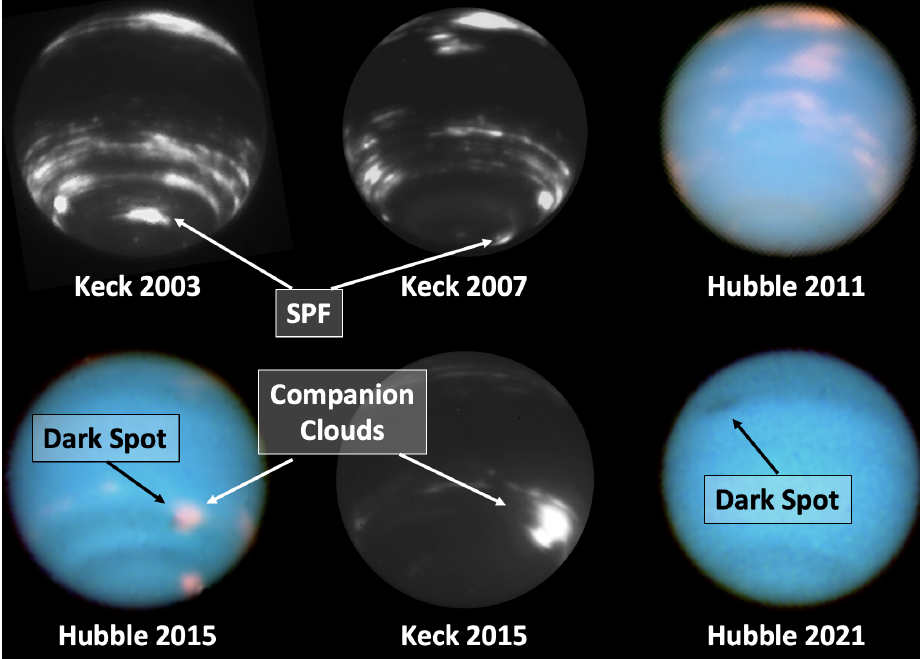
Figure 11. Neptune’s major cloud features in Hubble WFC3 and Keck H-band images from 2003 to 2021. The Hubble color composite in 2011 uses 845, 631, 467 nm in the R, G, B channels, respectively, while in 2015 and 2021, the G channel is 547 nm, and contrast and sharpness have been enhanced. Bright clouds are prominent in the H-band images, both in bands and in dark spot companion clouds, and the SPF appears on some dates [22,35,124]; dark spots are denoted in 2015 and